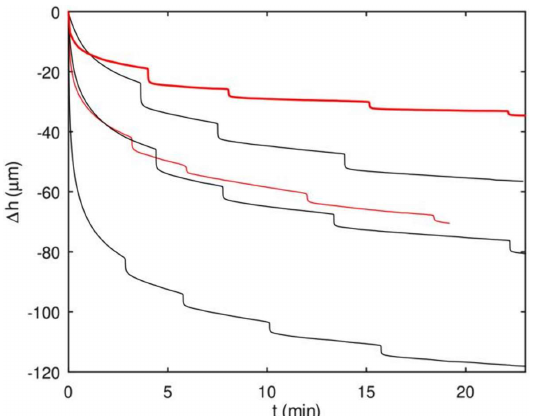
Fig. 3. Height decrease for the coarse torrefied powder (Tor5) for different normal stresses during the last part of the procedure. In red:  = 1 kPa. In black, from the top to the bottom,  = 7.0, 8.8 and 5.3 kPa. Thin red line: Initial loose state, thick red line: Initial dense